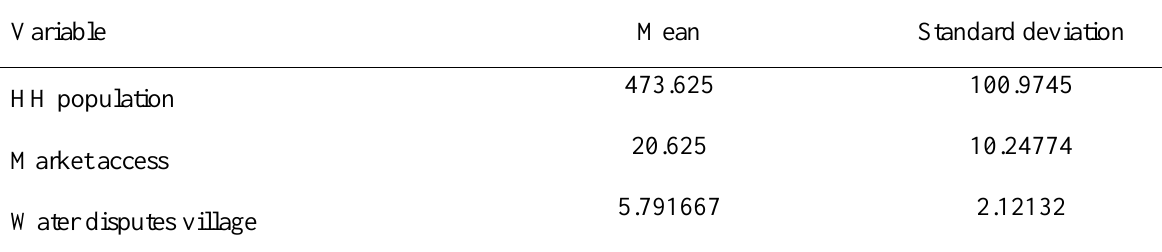
Table A1.3. Summary statistics of